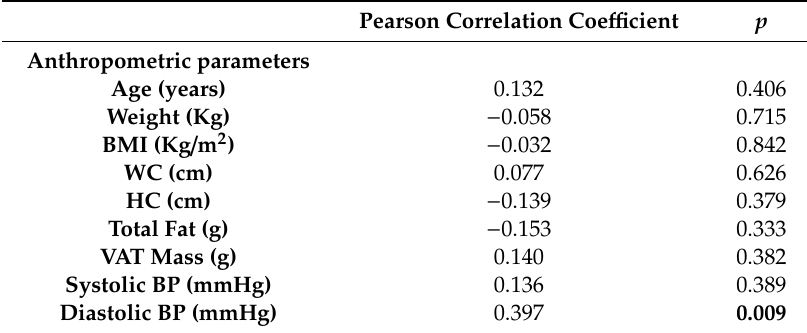
Table 2. Bivariate correlations between baseline serum FGF21 concentration and variables under consideration. Abbreviations: BMI, body mass index; WC, waist circumference; HC, hip